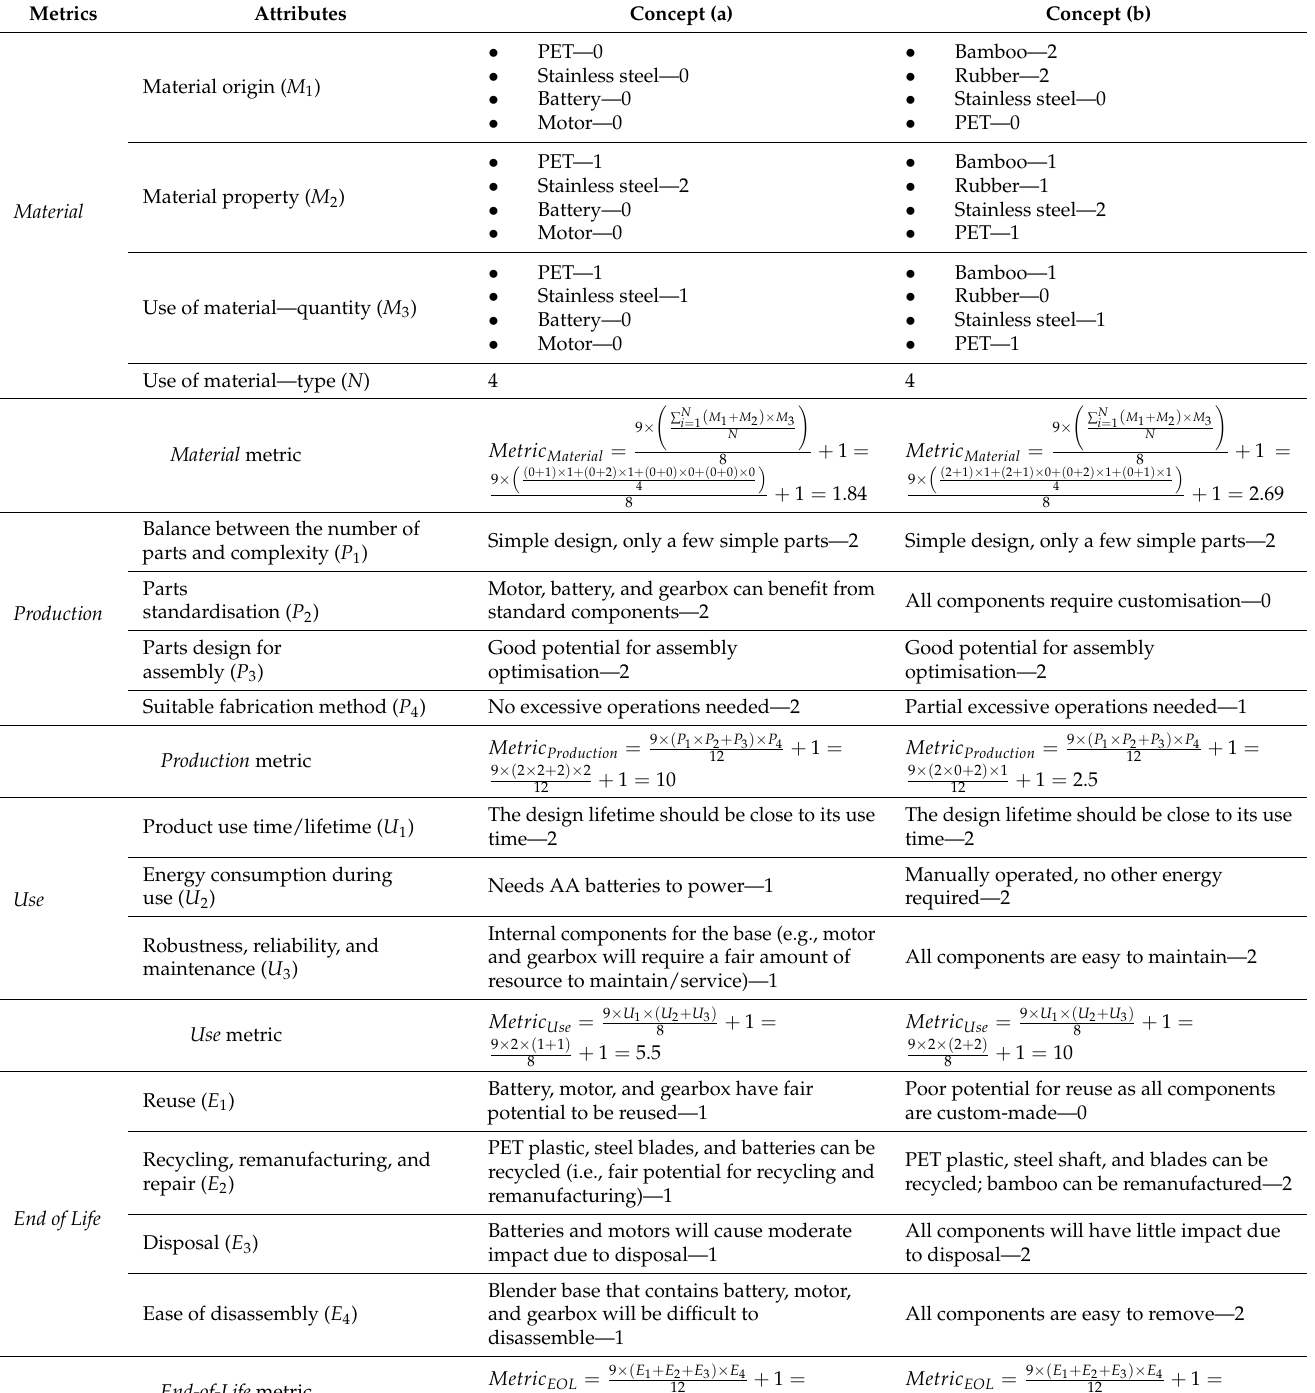
Table 8. Evaluation of the two blender